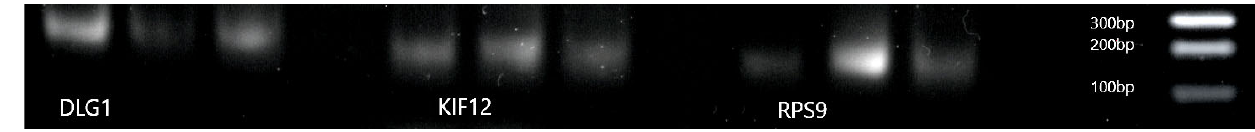
Figure 9. Agarose gel electrophoresis of RT ‐ qPCR amplification products of DLG1 (161 bp), KIF12 (164 bp), and RPS9 (140 bp) from 3 kidney samples.